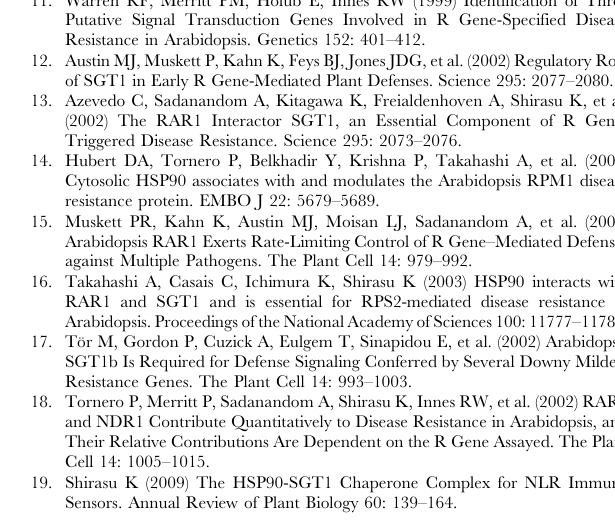
Figure S2 coi1 rsp alleles suppress some, but not all rar1 phenotypes for NB–LRR function. (A–B) Bacterial growth analysis of Pto DC3000( avrPphB ) (A) and Pto DC3000( avrRpt2 ) (B) Leaves of indicated genotypes were dip-inoculated [1]. Bacteria were counted for day 0 and day 3. Error bars represent 2 6 SE. Pairwise comparisons for all means for bacterial growth on day 3 were performed with One-Way ANOVA test followed by Tukey-Kramer after inoculation with high concentration Pto DC3000( avrRpm1 ) cotyledons were inoculated with Hpa isolate Emwa1. Asexual sprangiophores were quantified 7 days after inoculation on cotyledons for each of the indicated genotypes [2]. (Sp: sprangio- phore). The pathogen growth and HR assays were performed independently a minimum of three times with similar results. Figure S3 coi1 rsp alleles and sgt1b are insensitive to MeJA. Inhibition of root elongation by 50 m M MeJA for the indicated genotypes. The root elongation assay was performed three times with similar results. At least fifteen seedlings per genotype were measured in each repeat. Error bar represents 2 6 SE. Figure S4 coi1 rsp and coi1-16 mutations do not enhance RPM1 transcript levels. RT-qPCR analysis of the expression of RPM1 for indicated genotypes. The result displayed is one of three independent RT-qPCRs giving similar results. Figure S5 COI1 mutants studied express wild type levels of RAR1, SGT1 and HSP90 proteins. Western blot analysis of SGT1b, SGT1a, RAR1 and HSP90 protein levels for the indicated genotypes. RuBisCo levels stained by Ponceau S serve as loading control. The western blots were performed twice independently with similar results.